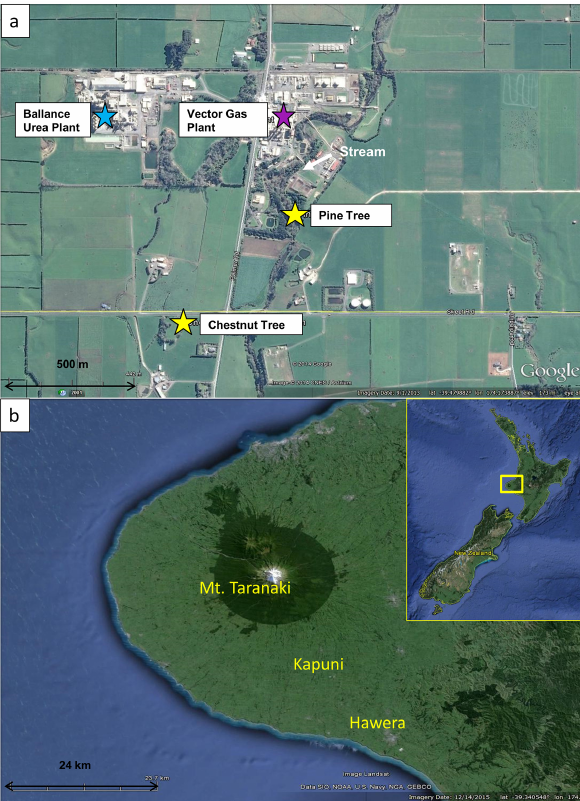
Figure 1. (a) Aerial view of Kapuni area, with the sampled pine and chestnut trees, Kapuni Stream, and Vector gas treatment plant and Ballance Agri-Nutrient urea plant labelled. (b) The Taranaki region, with Mount Taranaki, Kapuni, and Hawera labelled. Inset: New Zealand, with the Taranaki region outlined in